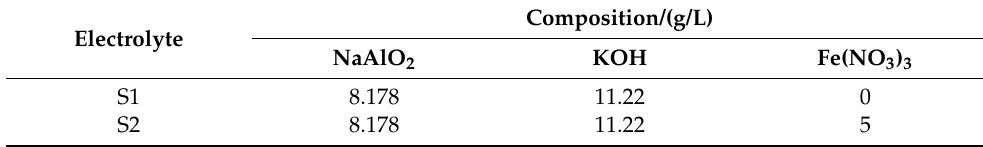
Table 1. Chemical compositions of the electrolytes used for the present MAO coatings. Electrolyte